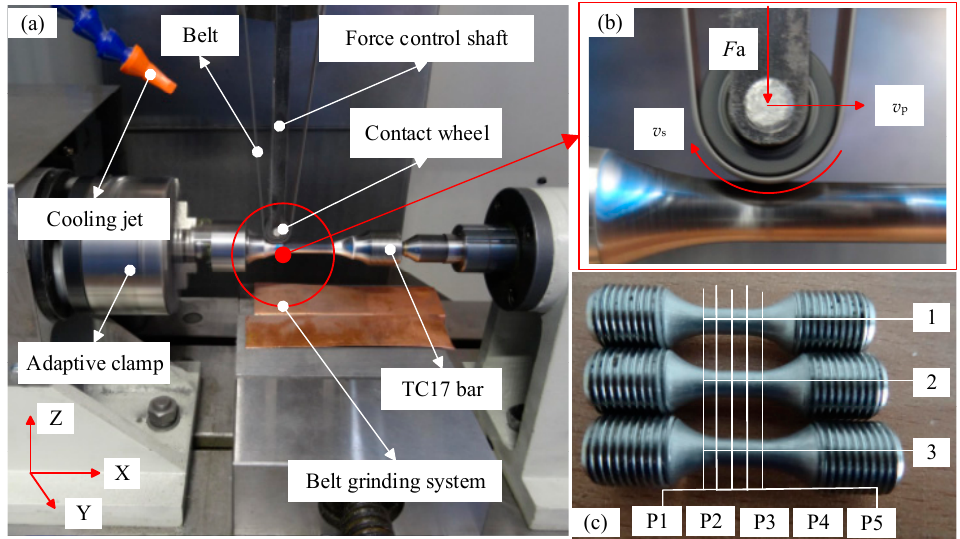
Figure 1. Experimental device and experimental materials: ( a ) grinding device with titanium alloy rods; ( b ) belt grinding system; ( c ) distribution of the five test points.